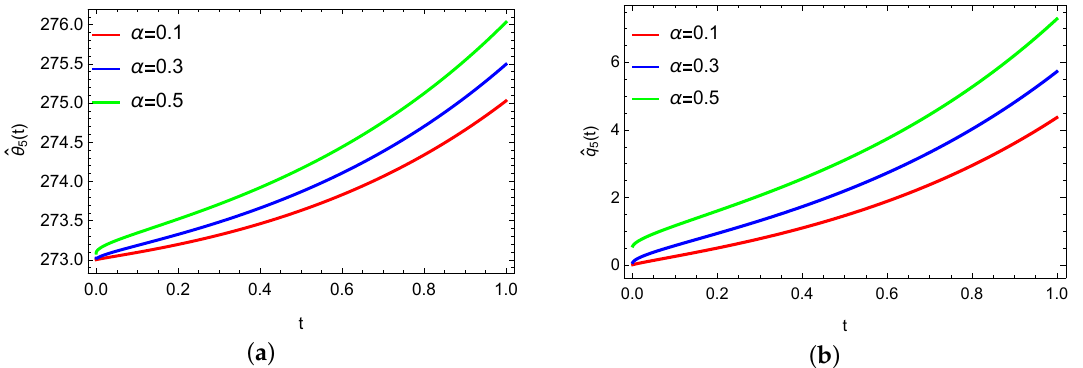
Figure 10. The reconstructed boundary conditions for different values of the order of the fractional derivative: ( a ) temperature distribution θ , ( b ) heat flux q